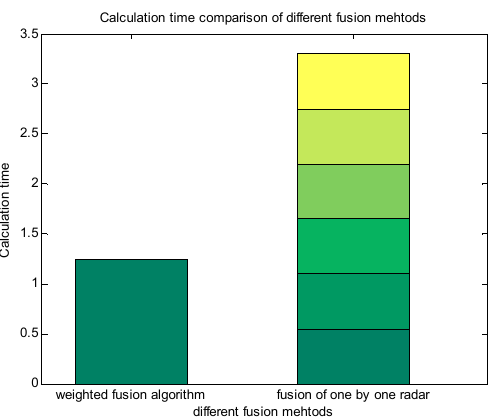
Figure 10. Comparison of errors of the observed target’s track.